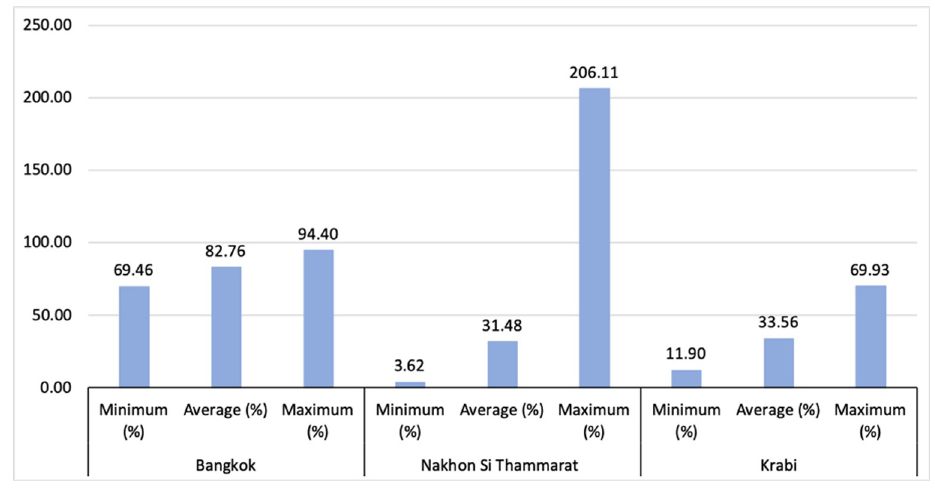
Fig 7. The ranges of sensitivity index (S 100 ) for each